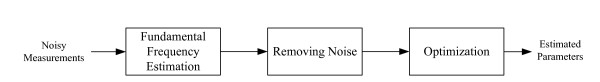
The implemented process of parameter estimation for oscillatory biochemical systems.